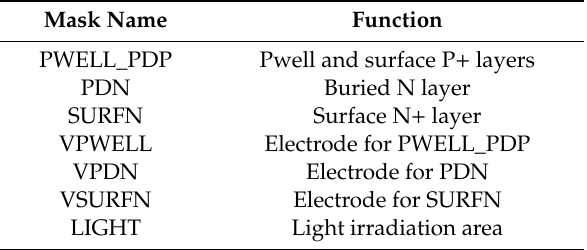
Table 1. Mask setup used in the SPECTRA device simulation as seen in Figure